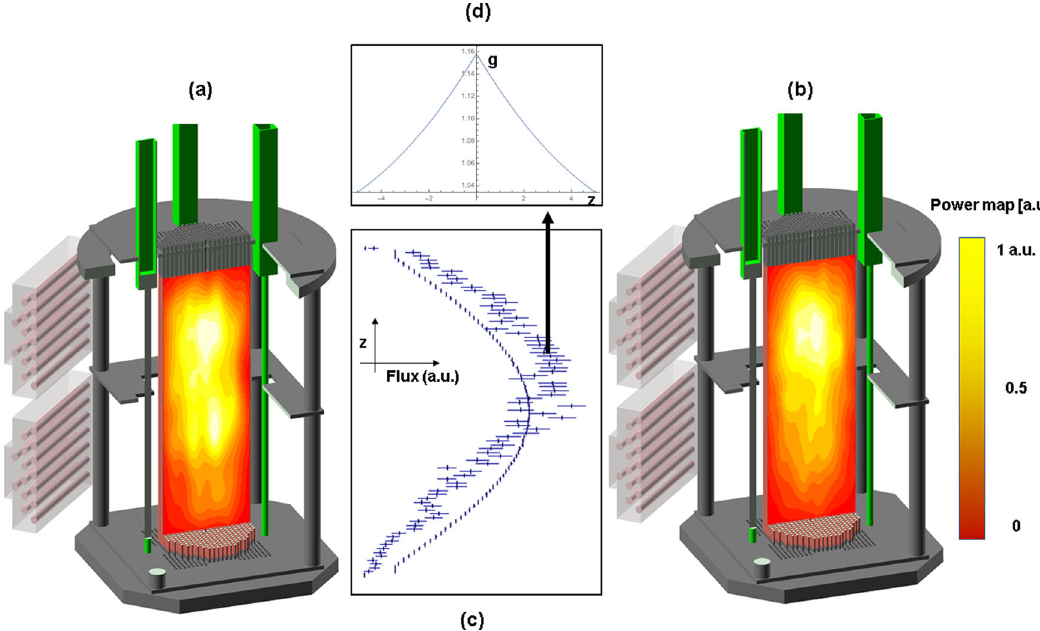
Fig. 6 Power spatial distribution within the Reactor Critical Facility (RCF). The 2D simulated power map is projected onto a 3D cut of the 1.2 mW RCF experiment. a The power map is averaged over 100 s of acquisition time (referred to as the “ averaged ” power map). b The power map corresponds to an acquisition time of 1 ms (hence it will be referred to as the “ snapshot ” power map). The corresponding axial power pro fi les are superimposed in c . In this last fi gure the noisy pro fi le associated to the “ snapshot ” view exhibits a non-Poissonian behavior typical of a clustered neutron population, which can be characterized by a peaked spatial correlation function g ( d ). The statistical error bars appearing in panel c are given by the MORET6 Monte Carlo neutron transport